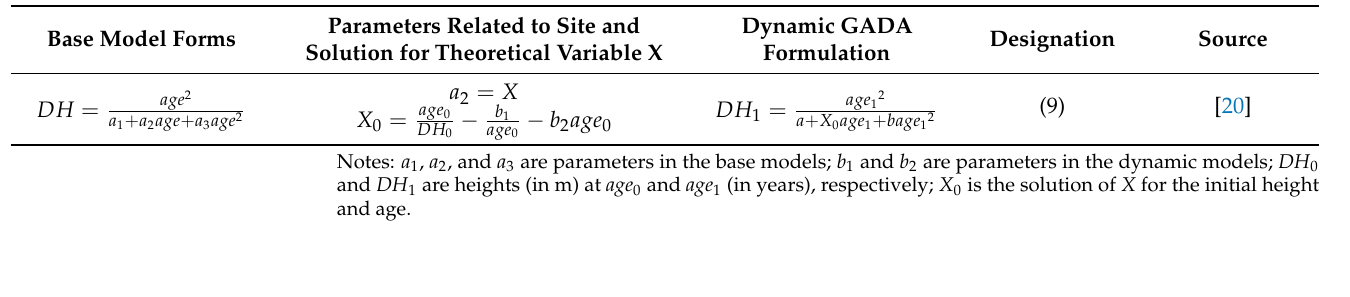
Table 3. The dynamic generalized algebraic difference approach (GADA) formulations with base equations used to model the dominant height